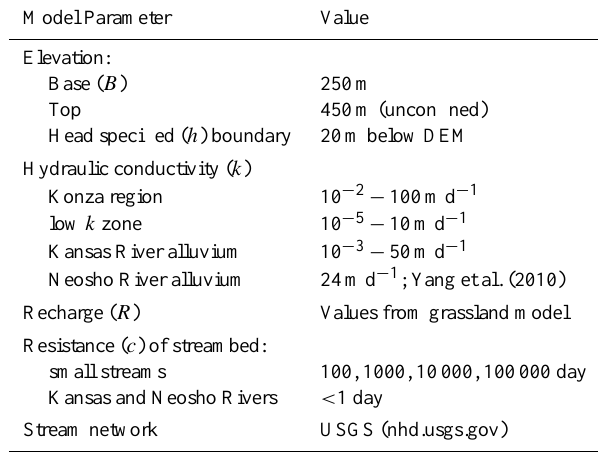
Fig. 4. Mean estimates for evapotranspiration, runoff, and recharge plus and minus one standard deviation for the soils of the study region. Table 2. Hydrogeology model